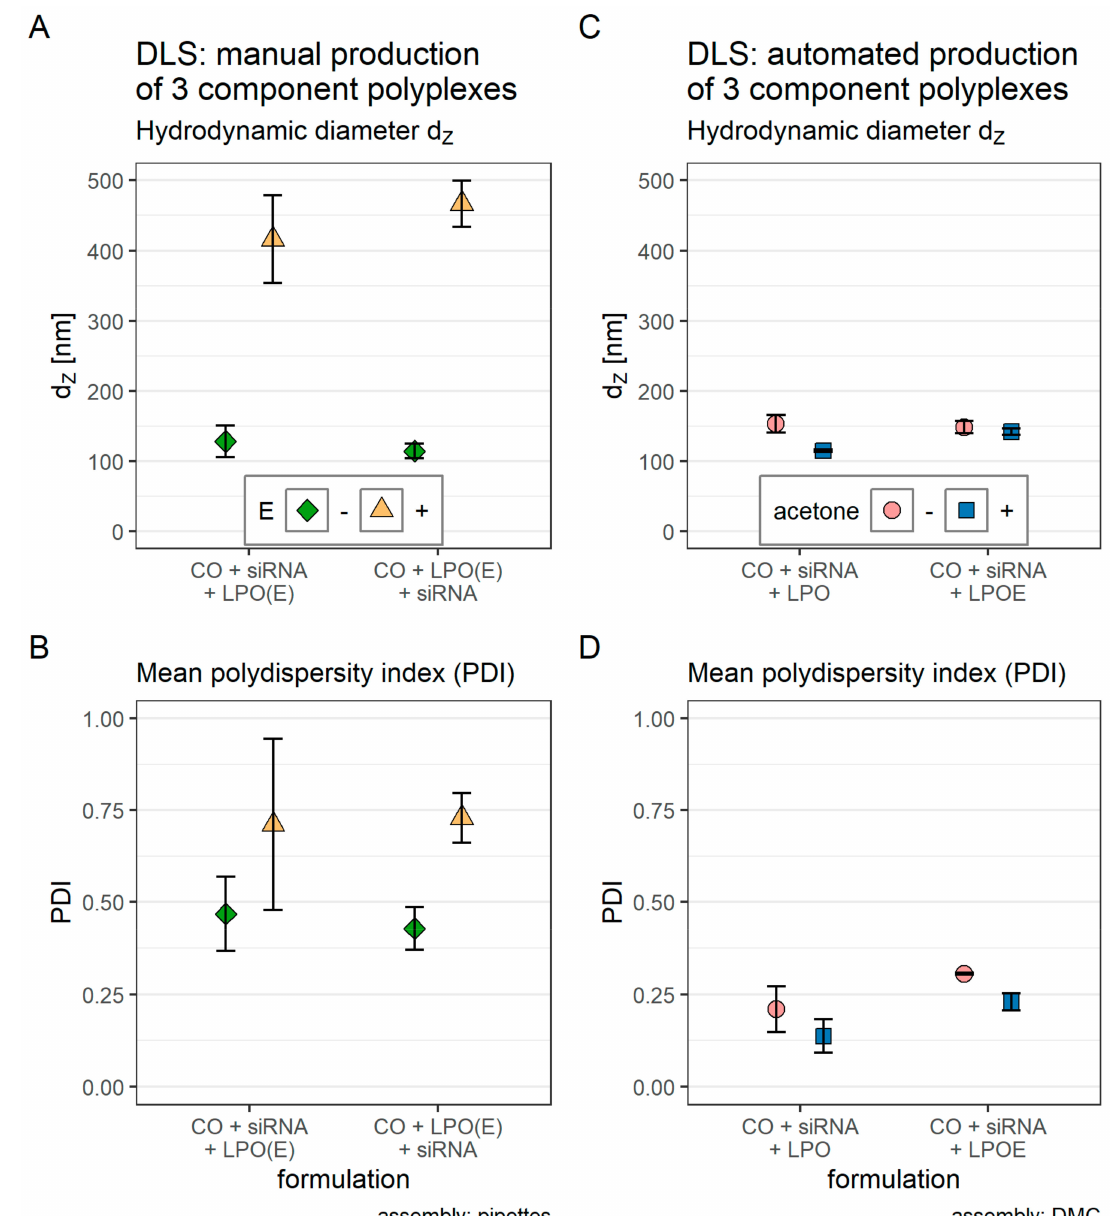
Figure 5. Manual or automated formulation of three component siRNA polyplexes. DLS data are represented as the mean of three measurements. Color and shape encode either the difference in the sequence of lipid anchored PEG12 oligomers (LPO, with or without E (glutamic acid), panel A , B ) or the difference in formulation conditions (oligomer CO dissolved in HBG with or without 50% acetone, panel C,D). ( A , B ): polyplexes were formulated manually by mixing all educts with pipettes. The mixing order is denoted on the x-axis. Orange triangle: the sequence of the LPO contains two additional glutamic acids. Green diamond: no additional glutamic acids. ( C , D ): polyplexes were formulated automatically inside the double meander channel (DMC, Figure 1) by the nanoparticle production system. Flow rates: siRNA 900 µ L/h (S4), CO 100 µ L/h (S3). LPO(E) 50 µ L/h (S2, two syringes). Total flow rate: 1100 µ L/h. The educts are denoted on the x-axis. Red dots: CO was dissolved in HBG only. Blue squares: CO was dissolved in HBG with 50% acetone. ( A , C ): mean hydrodynamic diameter (z-average). ( B , D ): Mean polydispersity index (PDI). Error bars correspond to 95% confidence intervals. N = 3. Raw data were selected from our previous publication [30], here presented in a new format. In Figure 5C,D, polyplexes from the three educts were produced automatically inside the double meander channel (DMC) by the nanoparticle production system. In the first mixing zone, CO and siRNA were mixed. The color and the shape of the data points indicate if